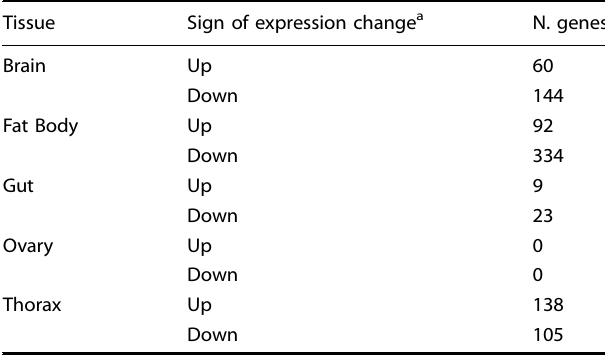
Table 1. Frequencies of differential gene expression in response to